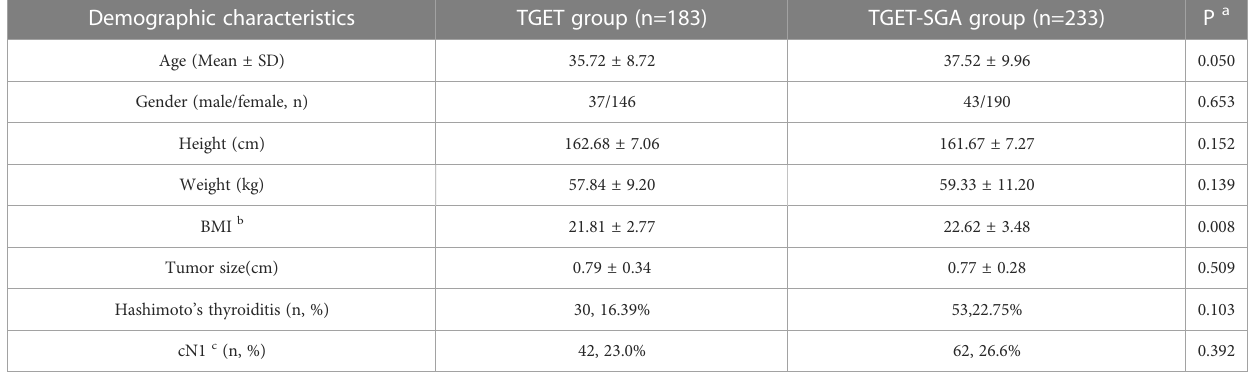
TABLE 1 The demographic characteristics of TGET and TGET-SGA